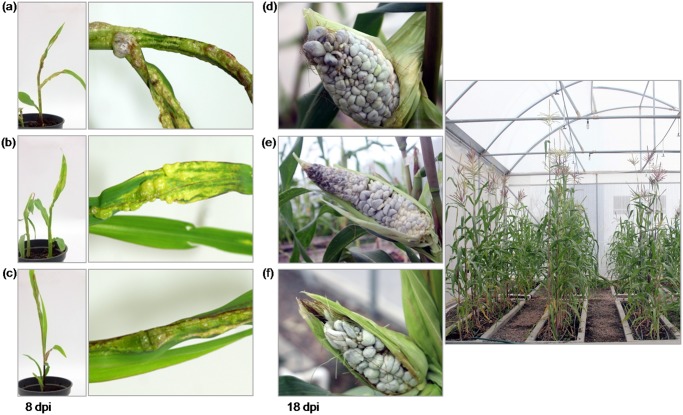
Tumors induced on maize plants, after inoculation with FB2-CTB strains paired with FB1 strain.Leaf tumors induced in 8-day-old maize seedlings inoculated with (a) FB1 x FB2, (b) FB1 x FB2-CTB 3 and (c) FB1 x FB2-CTB 4 crosses. Photos were taken 8 days post-inoculation (dpi). Corn smut galls (‘huitlacoche’) produced by inoculating with (d) FB1 x FB2, (e) FB1 x FB2-CTB 3 and (f) FB1 x FB2-CTB 4 crosses. Plants were grown under greenhouse conditions and photos were taken 18–20 dpi.